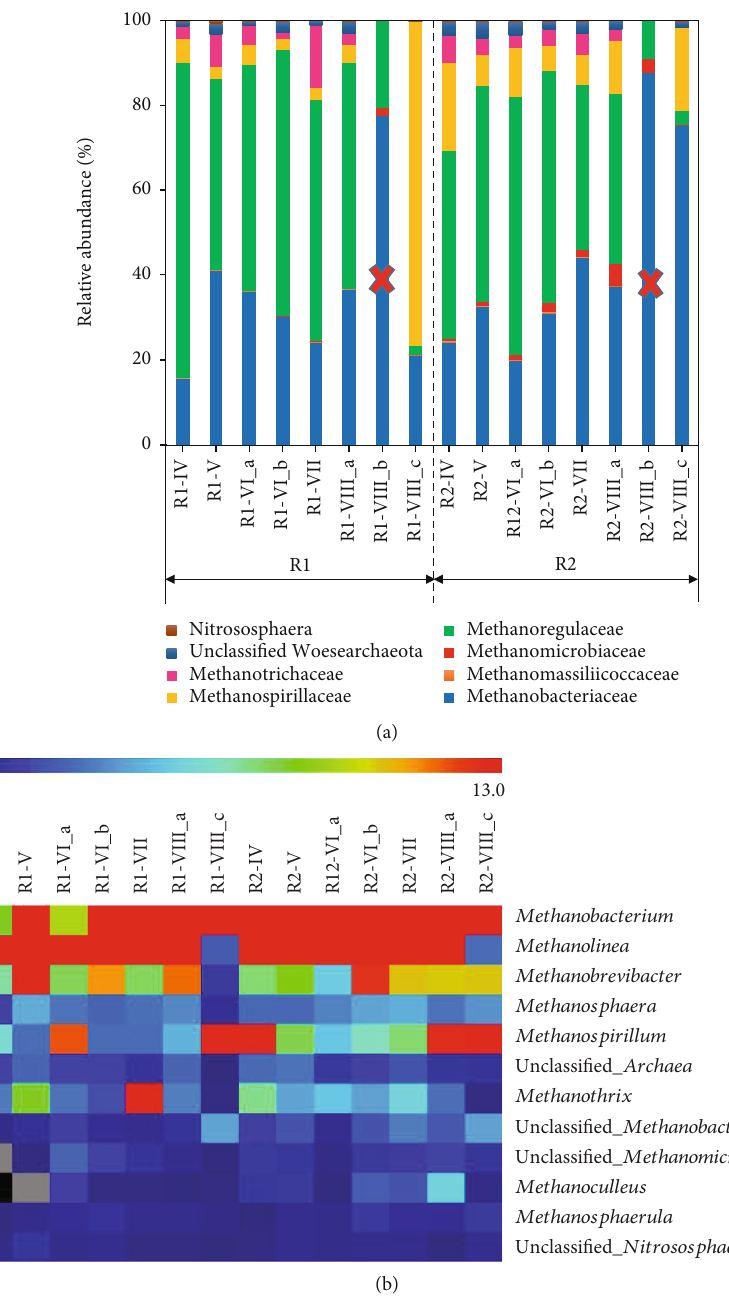
Figure 5: (a) Relative abundance of the archaeal community structure on the family level. R1_III b and R2_III b labelled with “ X ” are without consideration due to unideal archaea sequencing results. (b) Heat maps of relative abundance ( > 0.5%) of the most abundant archaeal ASVs of R1 and